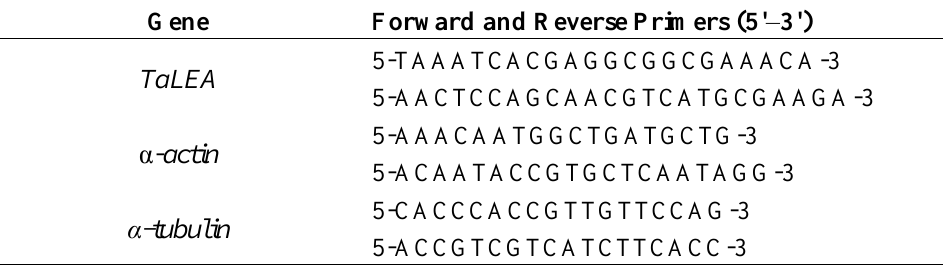
Table 2. Primer sequences used for quantitative RT-PCR